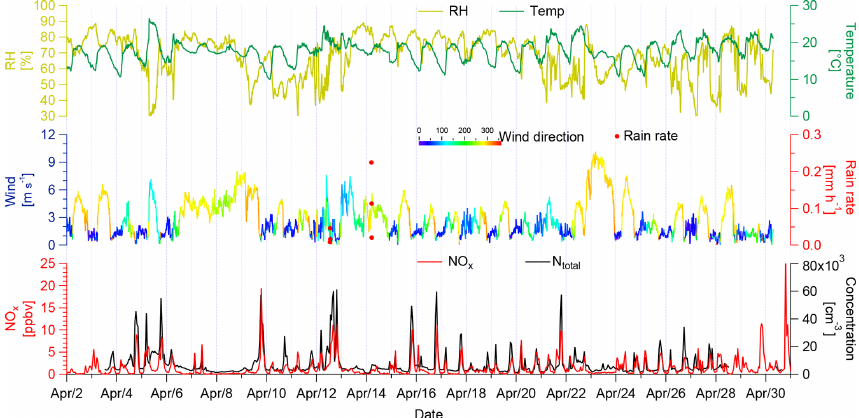
Figure 2. Time series of RH, temperature, wind speed, and wind direction with 10min resolution, NO x , and N total with 1h resolution.